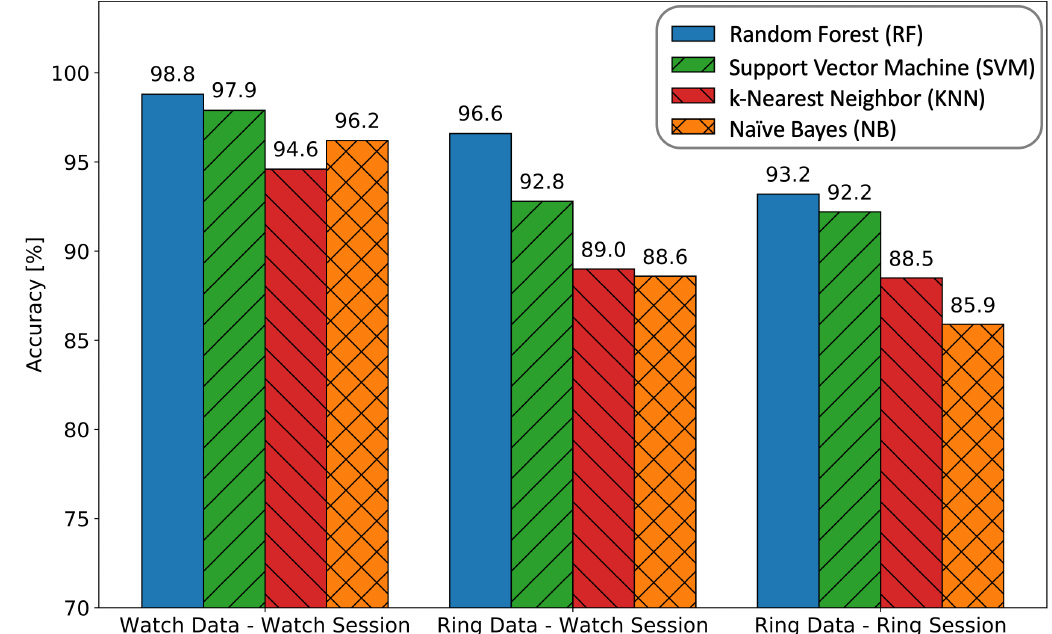
Figure 19. Best model representatives for every model type and all three data sets. The RF classifier performs best in all cases and achieves higher accuracy scores than the defined minimum of